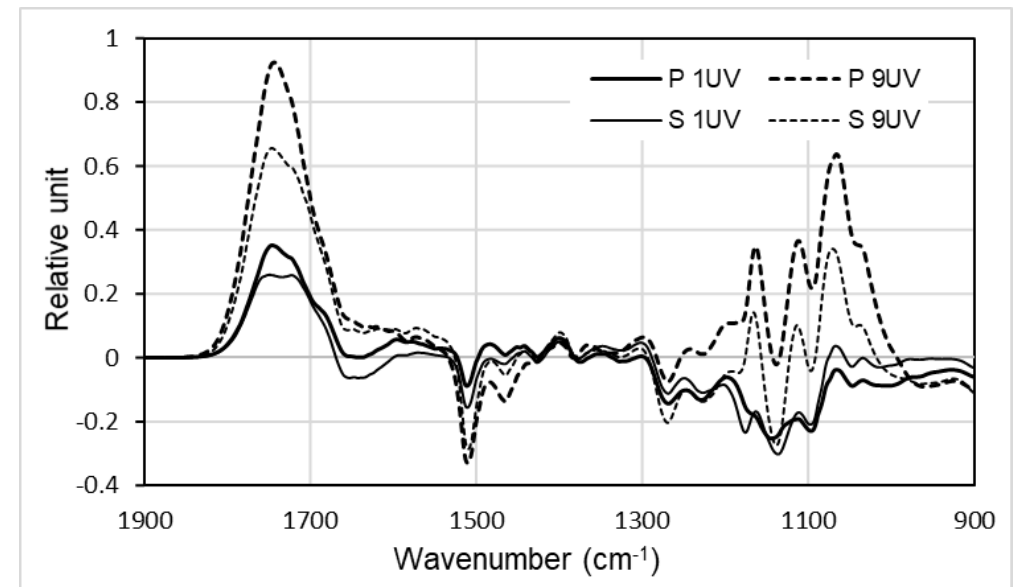
Figure 1. Difference FTIR spectra of Scots pine (P) and spruce (S) species generated by one-day and nine-day UV irradiation. The newly generated unconjugated carbonyl groups absorb between 1650 and 1820 cm − 1